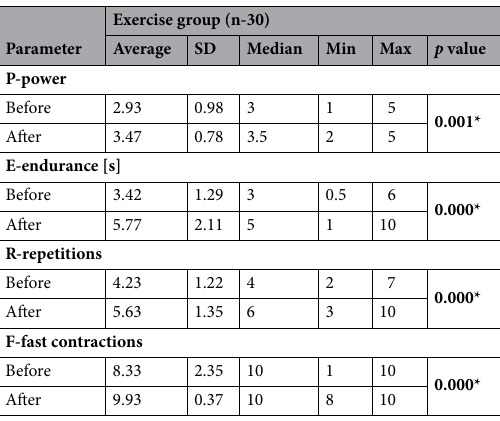
Table 5. PFM assessment results based on Perfect test in the exercise group. Values statistically significant are in bold. *Wilcoxon test.